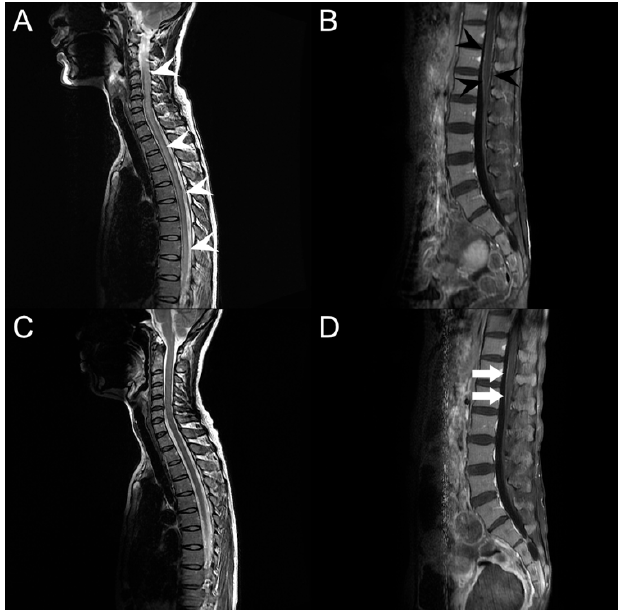
Figure 2. Spine magnetic resonance imaging. ( A ) T2-weighted sagittal imaging on admission shows abnormal intramedullary hyperintensity lesions from C1/2 to conus medullaris (white arrowheads). ( B ) T1-weighted sagittal gadolinium-enhanced imaging shows enhancement of pia mater on the conus medullaris (black arrowheads). ( C ) Intramedullary hyperintensity is improved after treatment. ( D ) Enhancement of pia mater remains even after treatment (white